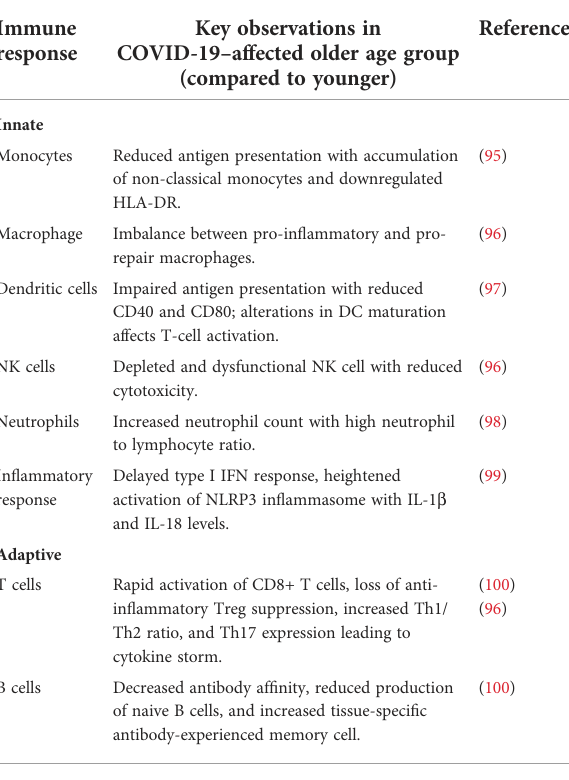
TABLE 3 Effect of age on the immune landscape of COVID-19 – affected